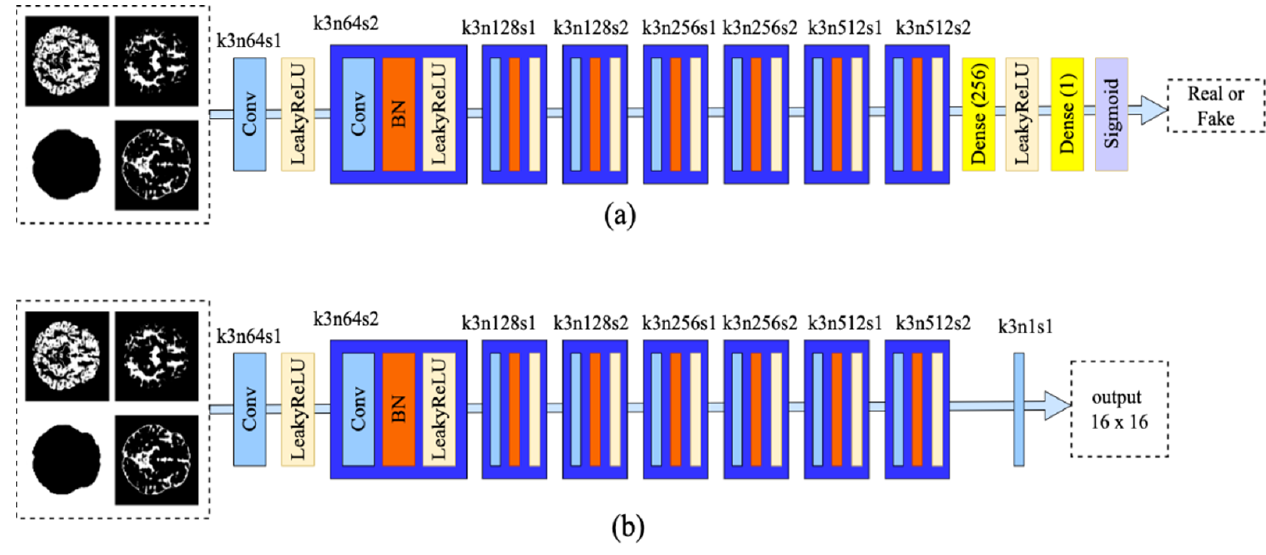
Figure 4. Architecture of the Discriminator Network of a ( a ) conditional GAN and ( b ) patchGAN with corresponding kernel size ‘k’, stride ‘s’, and a number of feature maps ‘n’ indicated for each convolutional layer.